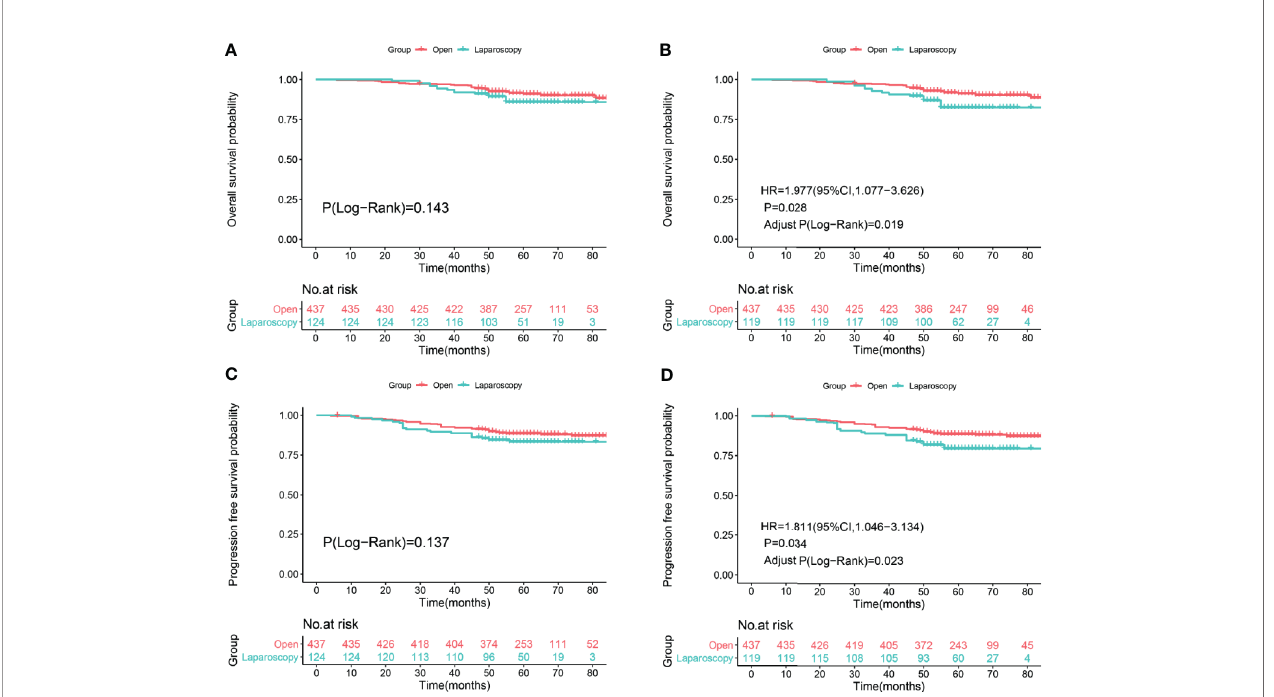
FIGURE 3 | Survival and recurrence outcomes between open and laparoscopic radically hysterectomy for stage IA2-IIA2 cervical cancer patients based on Federation International of Gynecology and Obstetrics (FIGO) 2018 staging system. (A) Overall survival (OS) curves of the patients before propensity score-based inverse probability of treatment weighting (PS-IPTW) analysis. (B) OS curves of the patients after IPTW analysis. (C) Progression free survival (PFS) curves of the patients before IPTW analysis. (D) PFS curves of the patients after IPTW